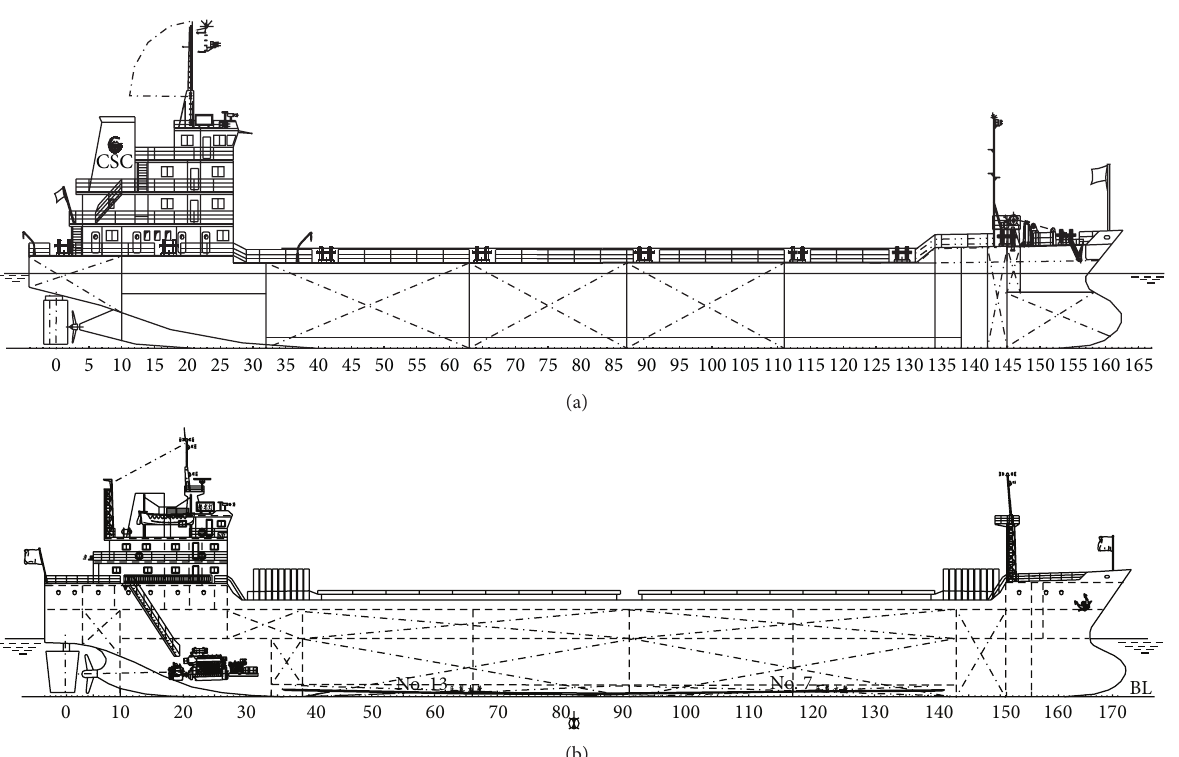
Figure 1: Schematic diagram of ships: (a) 5,000 DWT bulk carrier in Yangtze River; (b) 10,000DWT river-sea container ship in the lower Yangtze River and